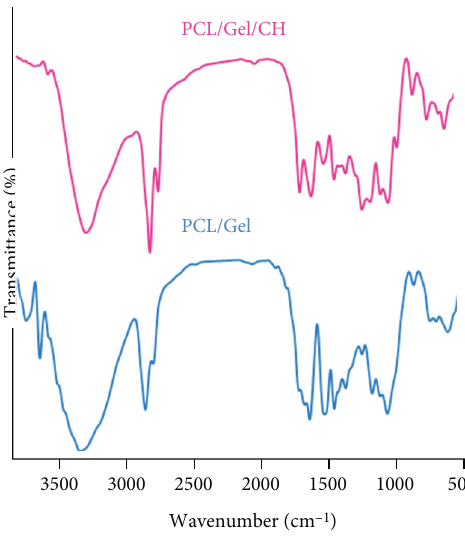
Figure 1: FTIR spectroscopy of PCL/Gel with and without Chrysin.